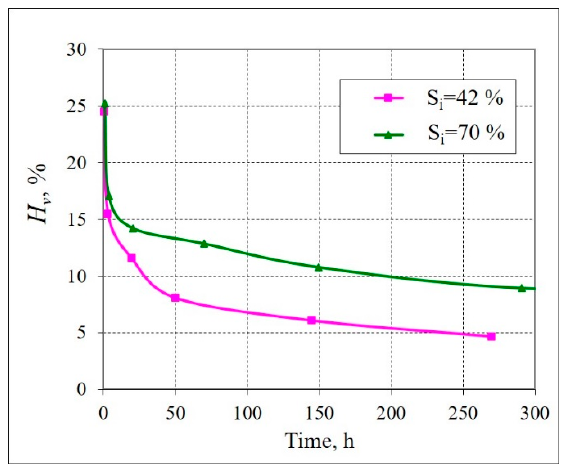
Figure 7. Dissociation kinetics of pore methane hydrates in frozen fine sand-1 samples with different ice contents at − 4 to − 5 °C and 0.1 MPa.